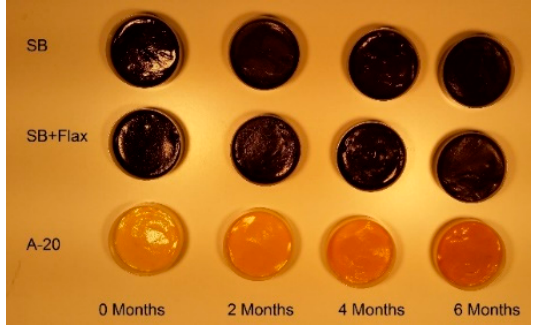
Figure 2. Appearance of LNS products after six months of storage at 40 °C.